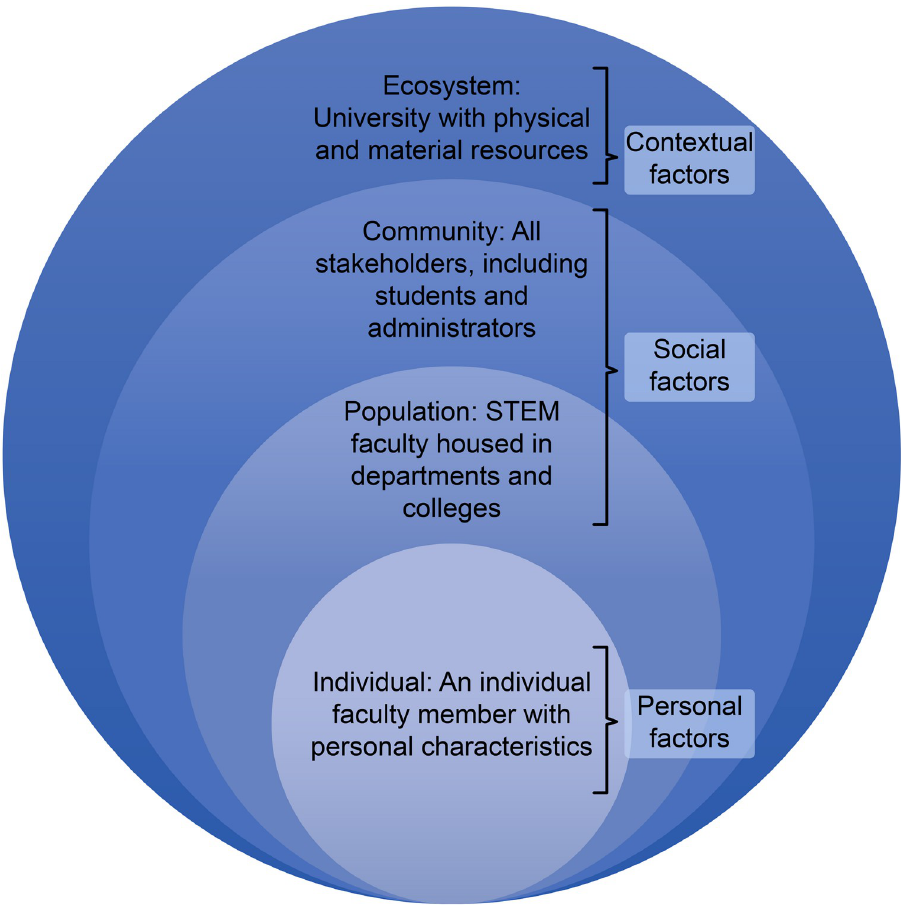
Fig 1. An ecological model of STEM faculty instructional decision-making. Individuals, with personal characteristics, are part of the population of STEM faculty within a department or college, who interact with other populations such as students and administrators to form the community. These living things interact with the nonliving parts of the environment, such as resources and classroom spaces, to form the ecosystem.